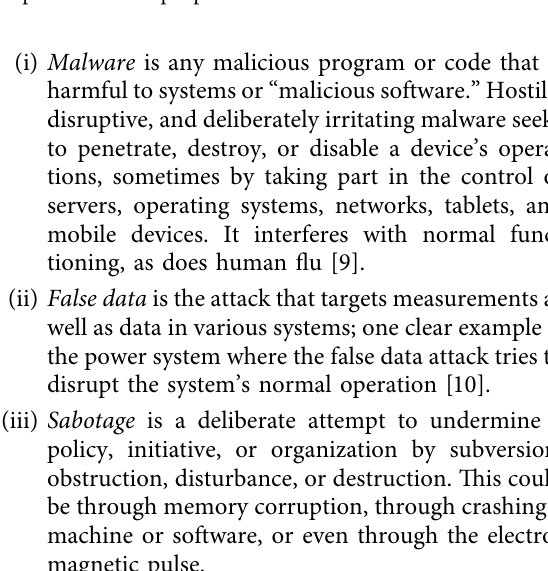
Figure 2: The average number of susceptible infected